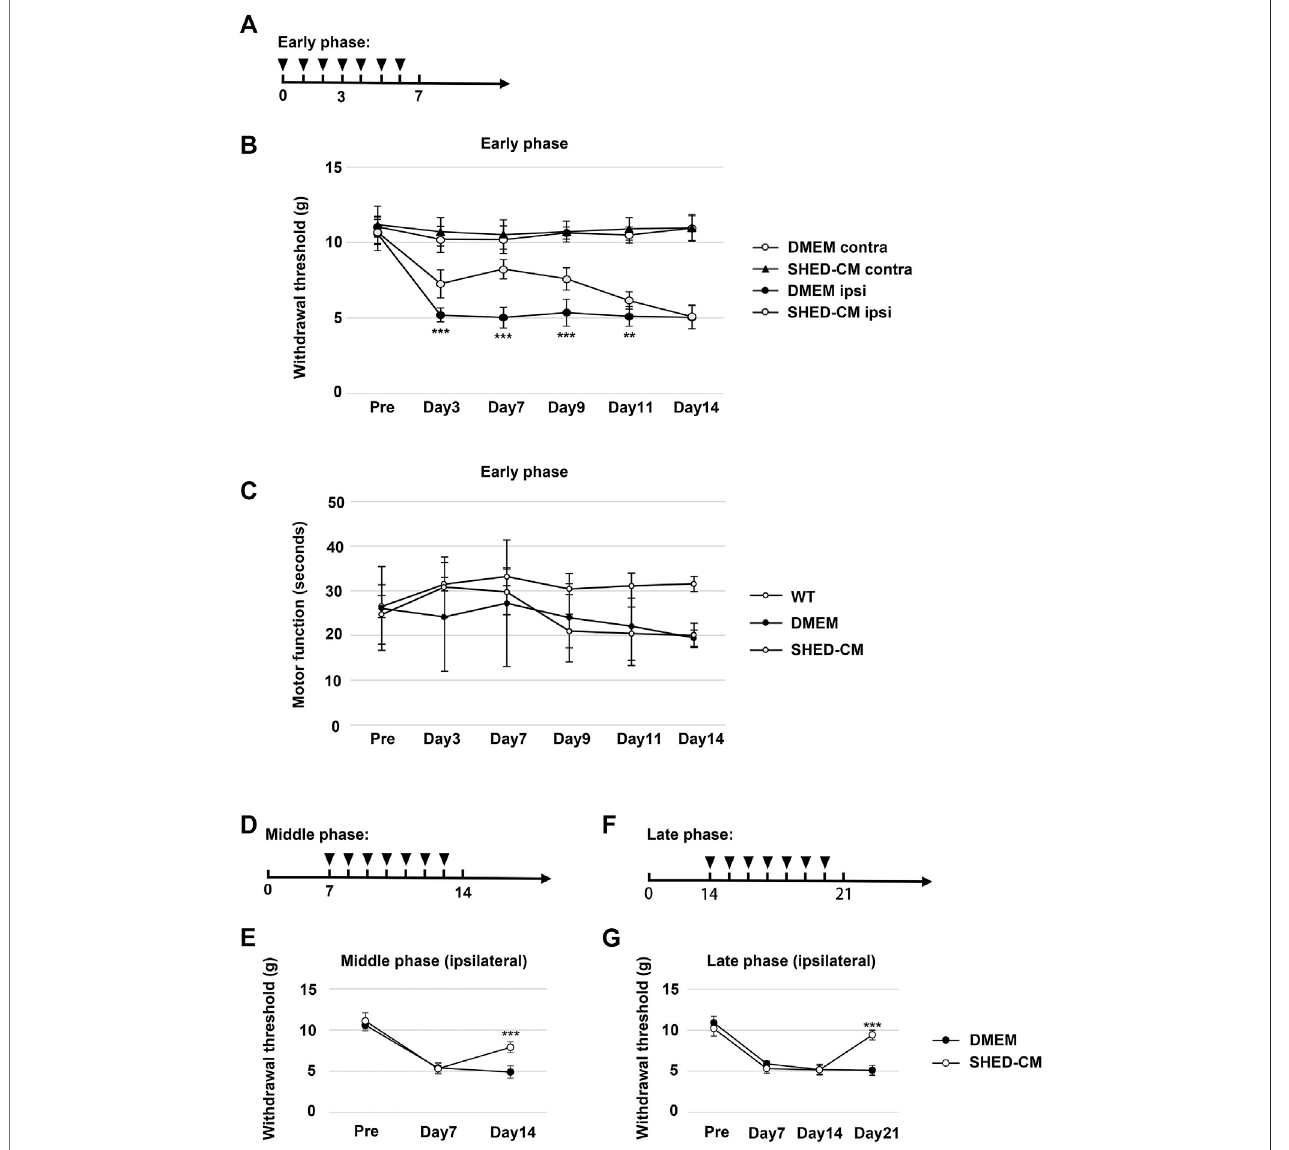
FIGURE 1 | Intravenous administration of SHED-CM attenuates partial sciatic nerve ligation (PSL)-induced neuropathic pain (NP). (A) Time course of SHED-CM treatment in the early phase model. (B) The ipsilateral paw withdrawal thresholds in the early phase. Student ’ s t -test ( n = 9 in each group). (C) Rotarod test in the early phase model ( n = 10 in each group). (D) Time course of SHED-CM treatment in the middle phase model. (E) The ipsilateral paw withdrawal thresholds in the middle phase. Student ’ s t -test ( n = 5 in each group). (F) Time course of SHED-CM treatment in the late phase model. (G) The ipsilateral paw withdrawal thresholds in the late phase. Student ’ s t -test ( n = 5 in each group). Data represent the mean ± SD. ** p < 0.01, *** p < 0.001 for the SHED-CM vs. DMEM.